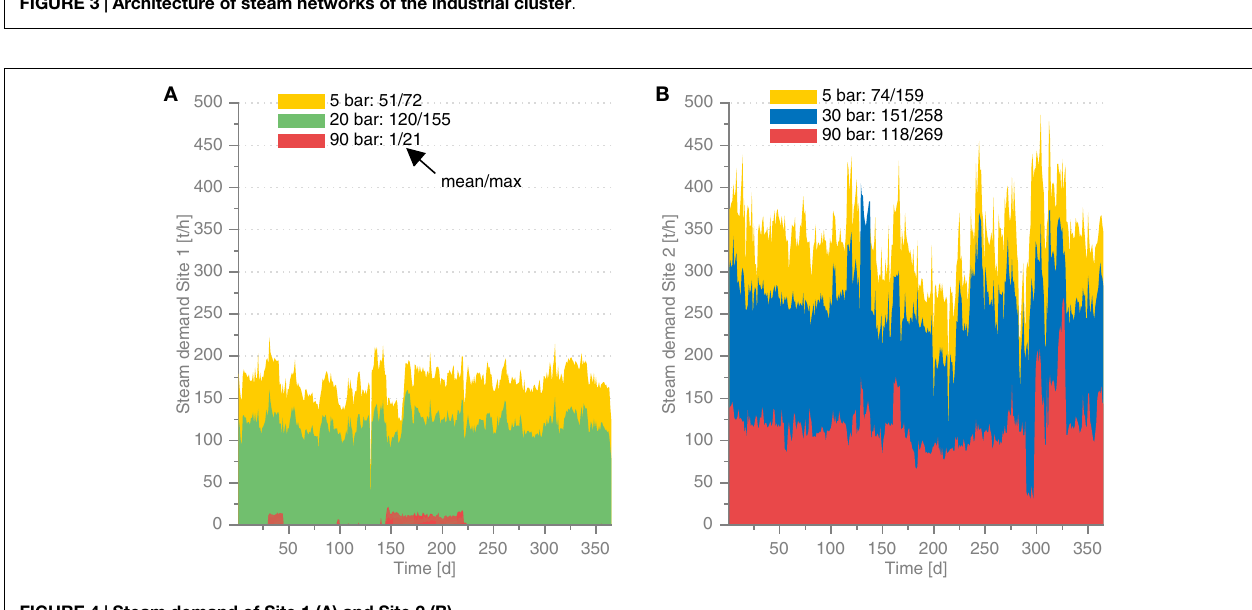
FIGURE 3 | Architecture of steam networks of the industrial cluster .